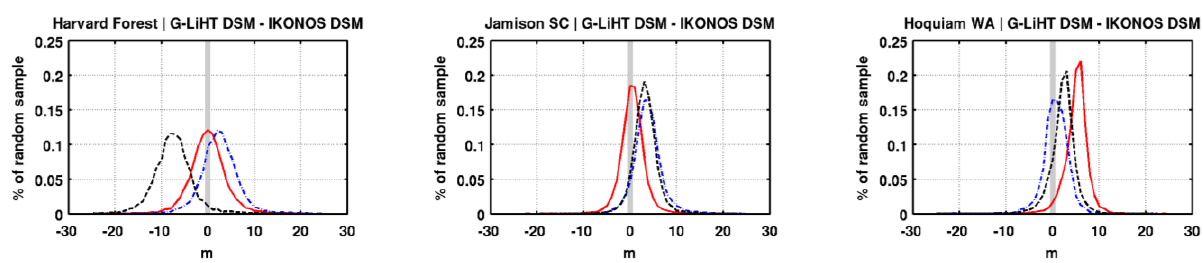
Figure 5. Height difference of LiDAR DSMs minus IKONOS DSMs. Data are presented as a histogram count percent of total from the standard normal distribution of randomly sampled pixels. The colors indicate no GCP DSMs with dashed black lines, one GCP DSMs with solid red lines, and 16 GCP DSMs are shown with dashed blue lines. Values not meeting criteria in Table 2 were excluded from